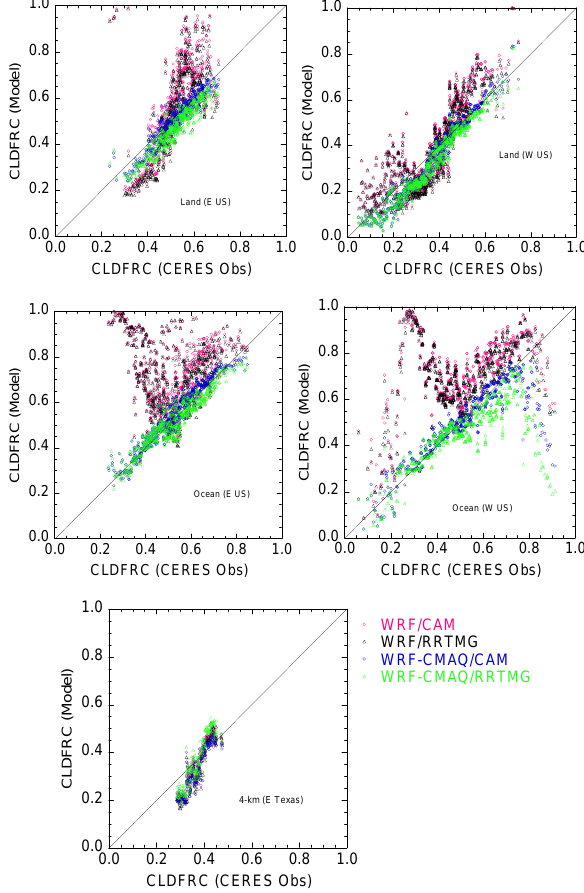
Figure 23. Same as Figure 11 but for cloud fractions (CLDFRC) for September of 2006.